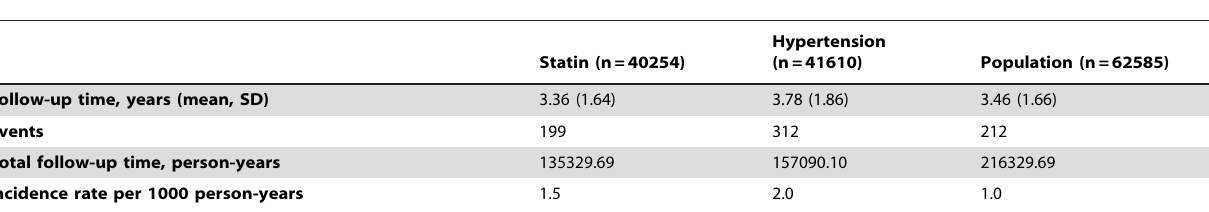
Table 2. Patient follow-up, low-energy hip fracture, and incidence rates in the study cohorts.